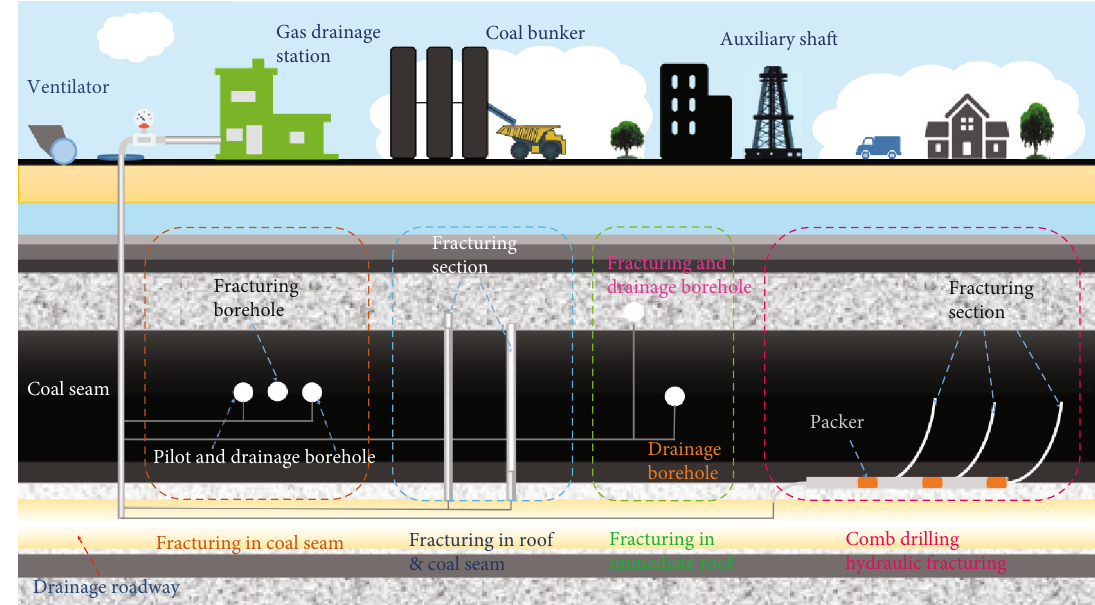
Figure 1: Underground hydraulic fracturing technologies.